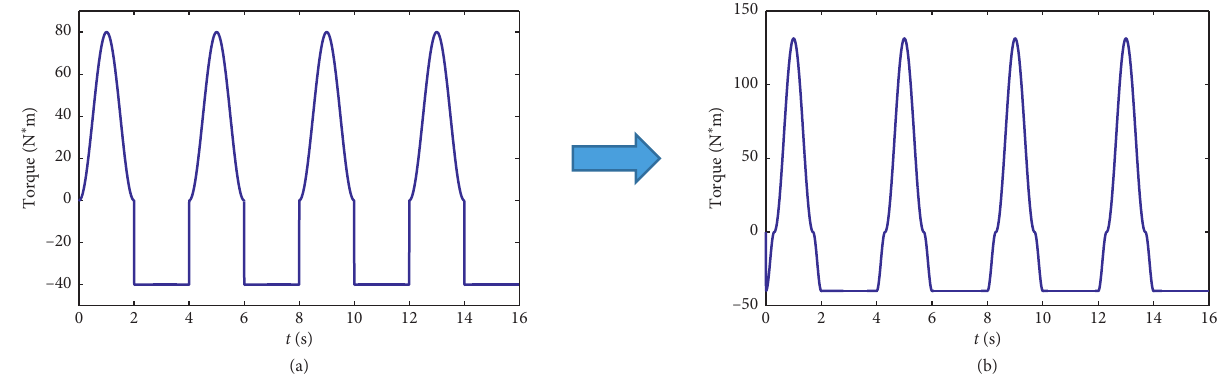
Figure 12: The velocity curve in the x -direction. (a) Unmodified curve. (b) Modified curve.